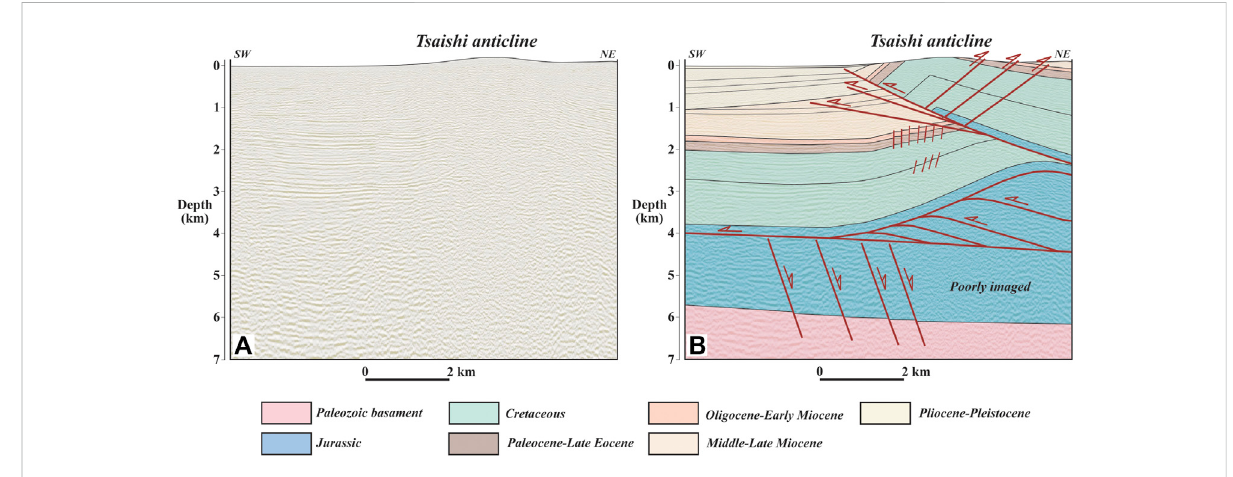
seismic re fl ection pro fi les and constraints on balanced cross- section geometry comprise structural information (position of stratigraphic contacts, faults, thrusts, dips) and thicknesses of lithostratigraphic units. For interpretation of 2D depth- migrated seismic pro fi les, construction of regional